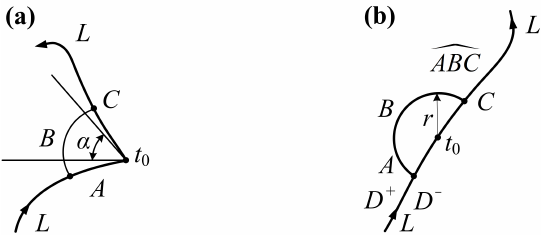
Figure 2. ( a ) The arc ABC of a piecewise smooth L , ( b ) the arc of a smooth contour L